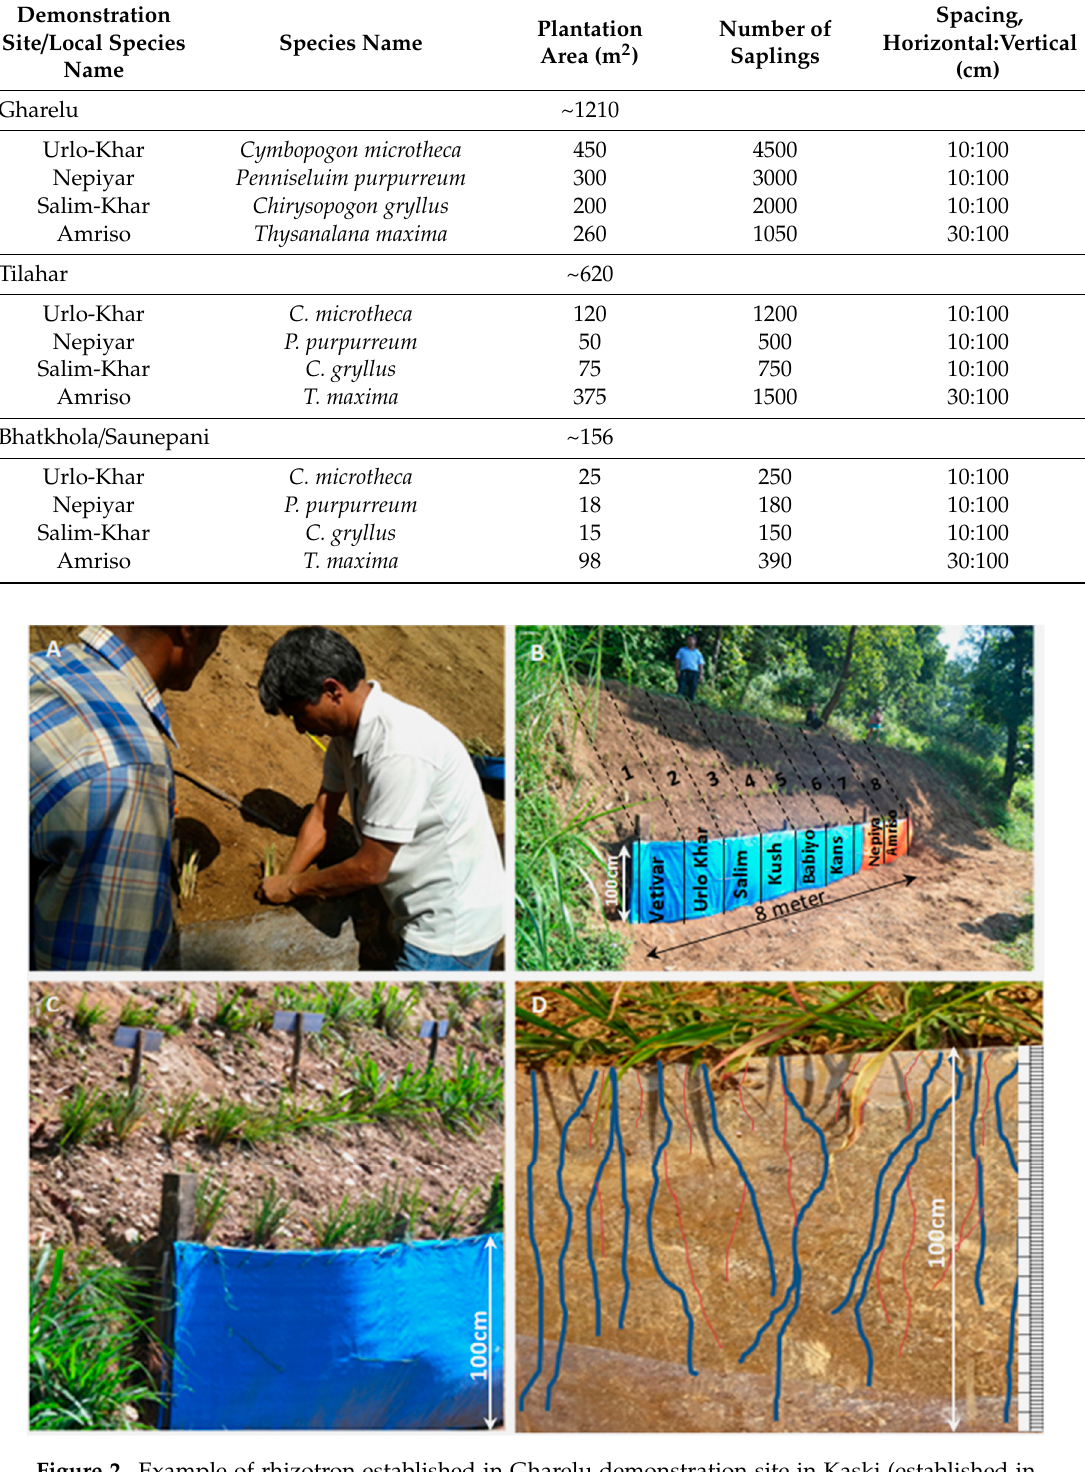
Figure 2. Example of rhizotron established in Gharelu demonstration site in Kaski (established in November 2014) marked on a field: ( A ) during the plantation; ( B ) just after completion; ( C ) after three months of the establishment; ( D ) tracing of roots. The red line denotes roots of Vetiver grass ( Chrysopogon zizanioides ) after six months (April 2015), and the blue line denotes old roots of the same species as seen from the rhizotron window after 12 months (November 2015).